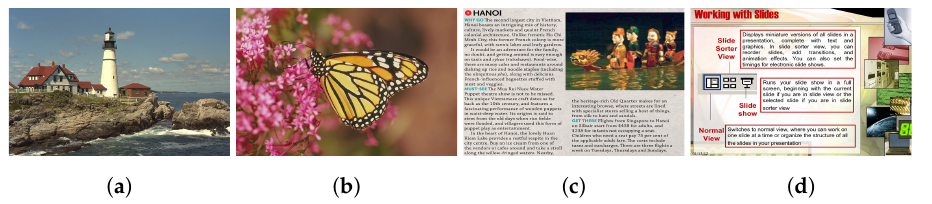
Figure 1. Examples of traditional natural images and screen content images. ( a , b ): natural images from LIVE. ( c , d ): screen content images from